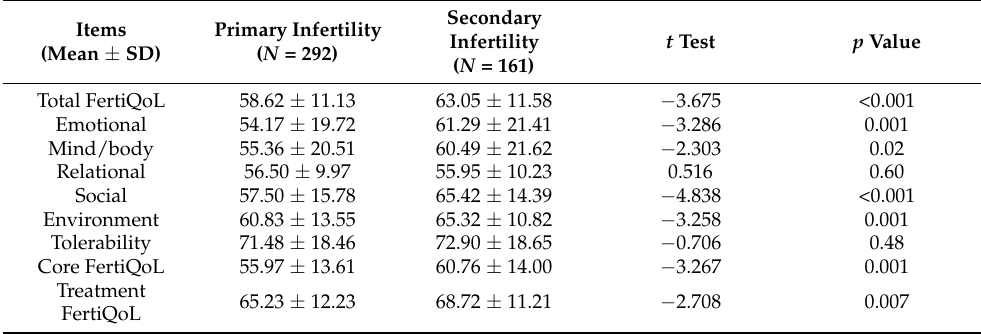
Table 3. Characteristics of average indicators of FertiQoL in groups with primary and secondary infertility.